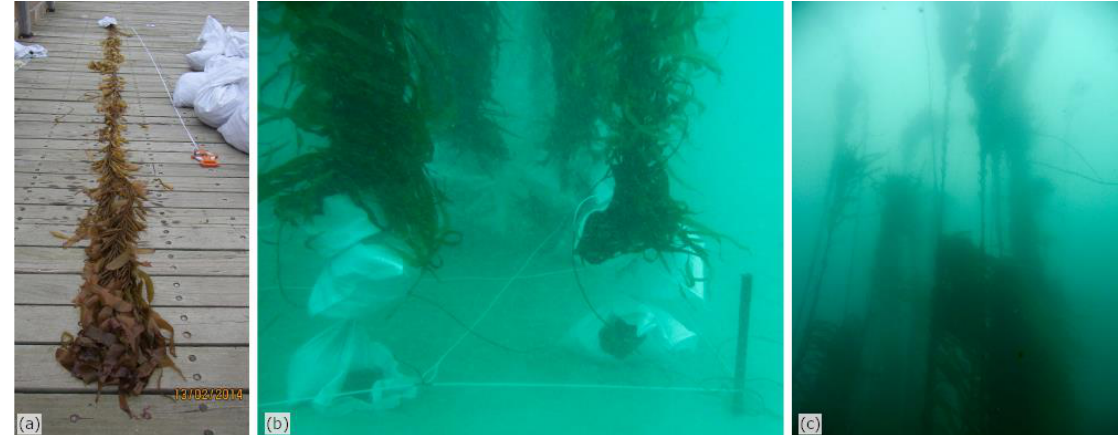
Figure 1. The experimental setting: ( a ) individual plant being measured at the port after harvesting; ( b ) setting of the bagged holdfasts in the quadrat; and ( c ) "dense" forest patch in situ. Table 1. Tag number, length, and wet weight of each plant harvested, and their use in the two experiments. Length